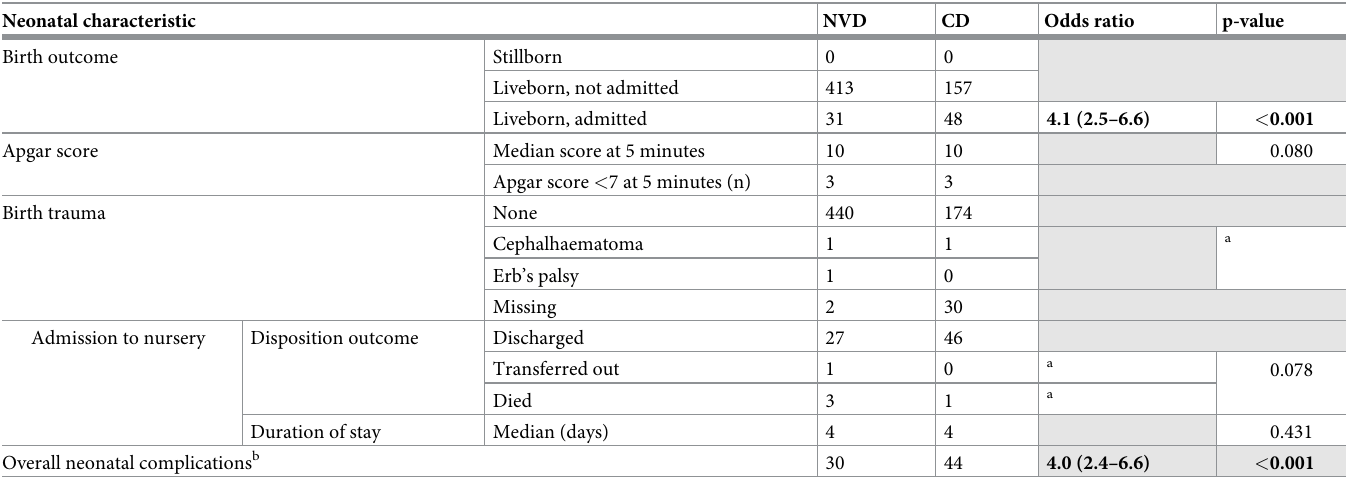
Table 6. Neonatal